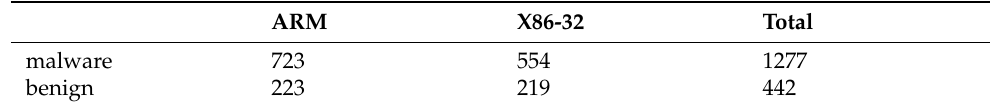
Table 1. Sample distribution for each CPU